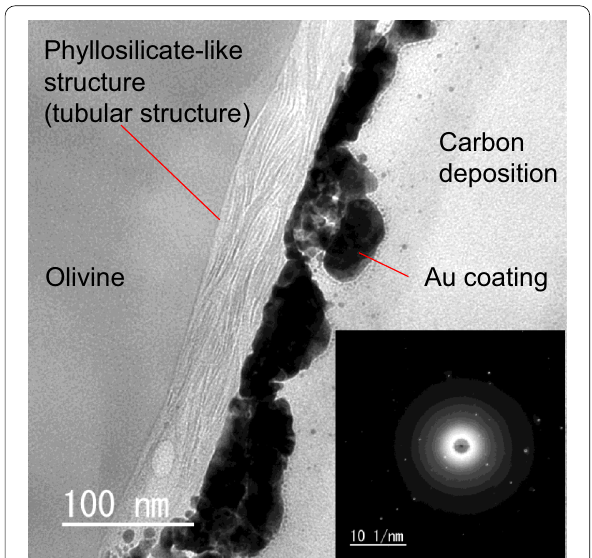
Fig. 4 A TEM image of a phyllosilicate-like structure near the surface area of olivine that had reacted (grain B), along with a diffraction pattern of the structure (lower right). The phyllosilicate-like structure was a tubular anastomosed